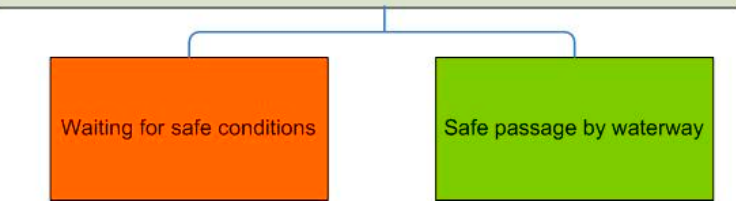
Figure 8. A novel flowchart of safety analysis for ships and bridge structures during oversized cargo transport on inland waterways with a shallow riverbed.